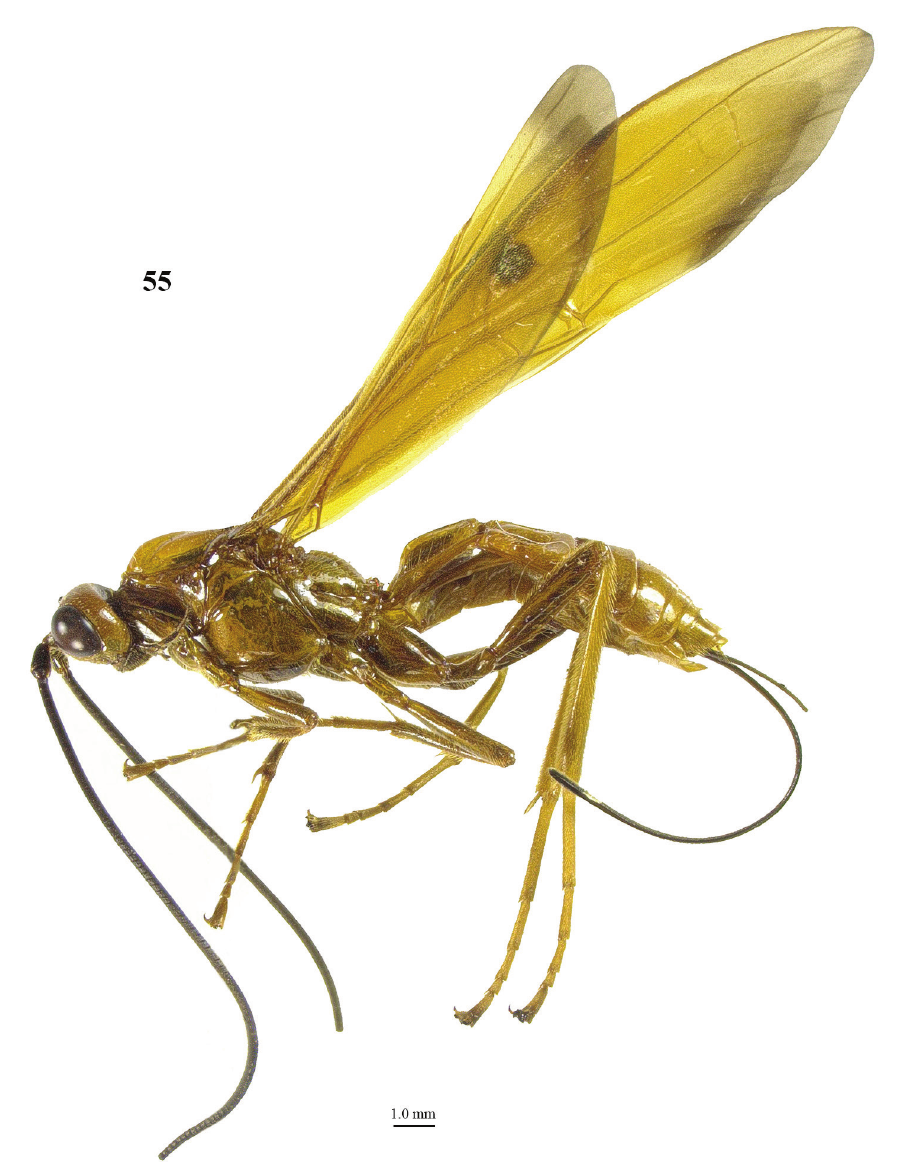
Figure 55. Maculibracon hei sp. n., ♀ , holotype, habitus lateral. lamelliform, with few long setae ventrally; hypoclypeal depression 0.3 times as wide as minimum width of face (Fig. 62); frons shallowly concave behind antennal sock- ets, rugose, with a rather shallow median groove (Fig. 62); vertex smooth, with few long setae and shiny; stemmaticum distinctly protruding; OOL:diameter of posterior ocellus:POL = 25:10:8; in dorsal view length of eye 2.3 times temple; temples